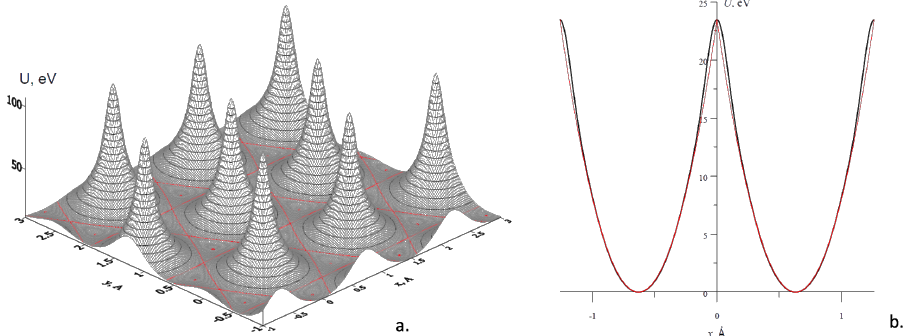
Figure 2. Continuous potentials at axial and planar channeling of relativistic positrons in crystals. ( a ) Axial channeling in diamond C<111> at a room temperature; ( b ) Planar channeling in diamond C(110) at a room temperature. The parabolic approximation for a planar potential shown in red reveals good enough fitting that may simplify the analytical analysis for rapid estimations. For both cases the minima of the potential wells are formed in a less-atomic-dense space in the transverse cross-section to the direction of channeling. Reproduced from